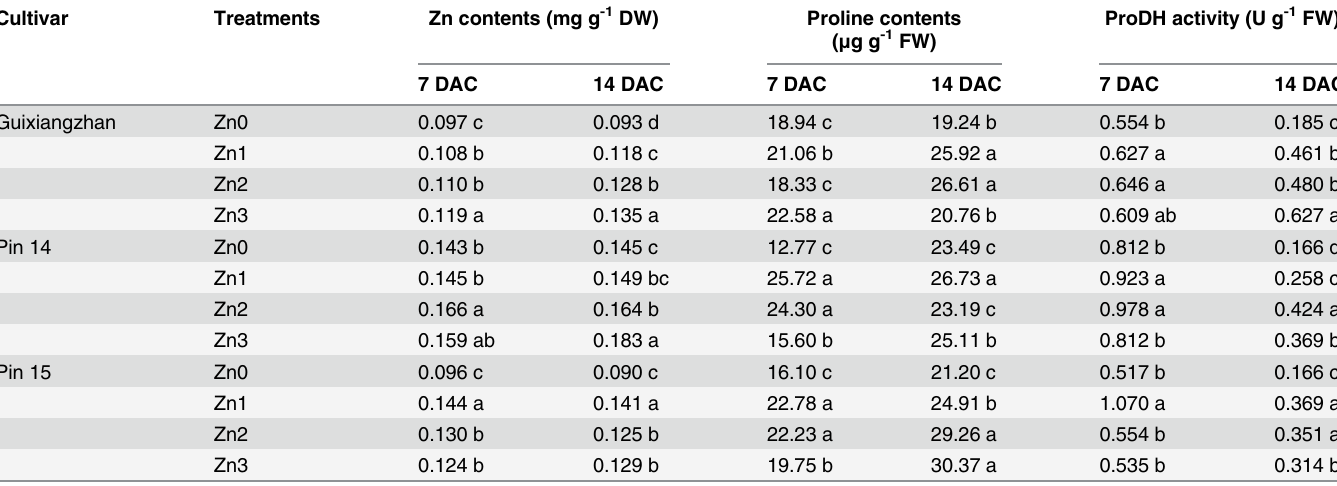
Table 1. Effect of Zn supplementation on Zn and proline contents as well as ProDH activities in grains of detached aromatic rice panicles in vitro . Cultivar